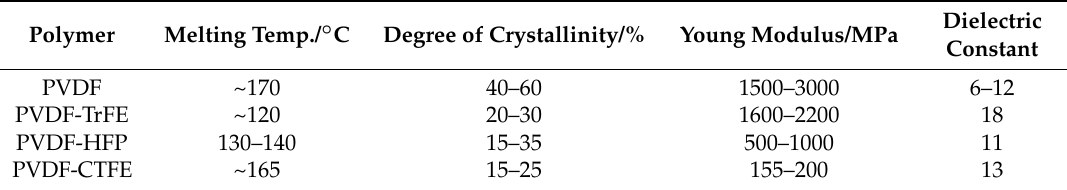
Table 2. Main properties of PVDF and its copolymers